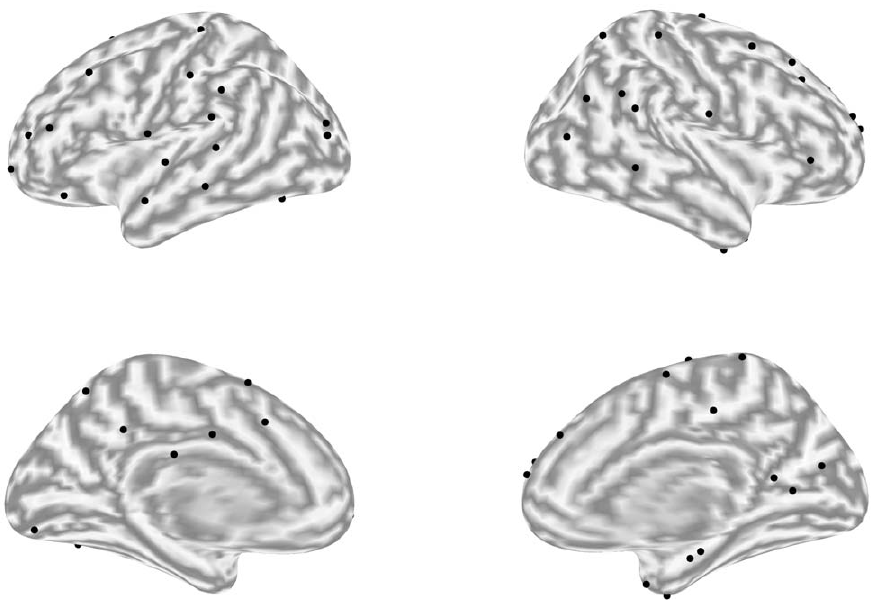
Figure 4. Possible simulated source locations. External and internal views of the brain hemispheres are shown in the upper and lower part of the image respectively. The algorithm for the source site choice aims to minimize the spatial pattern overlap.